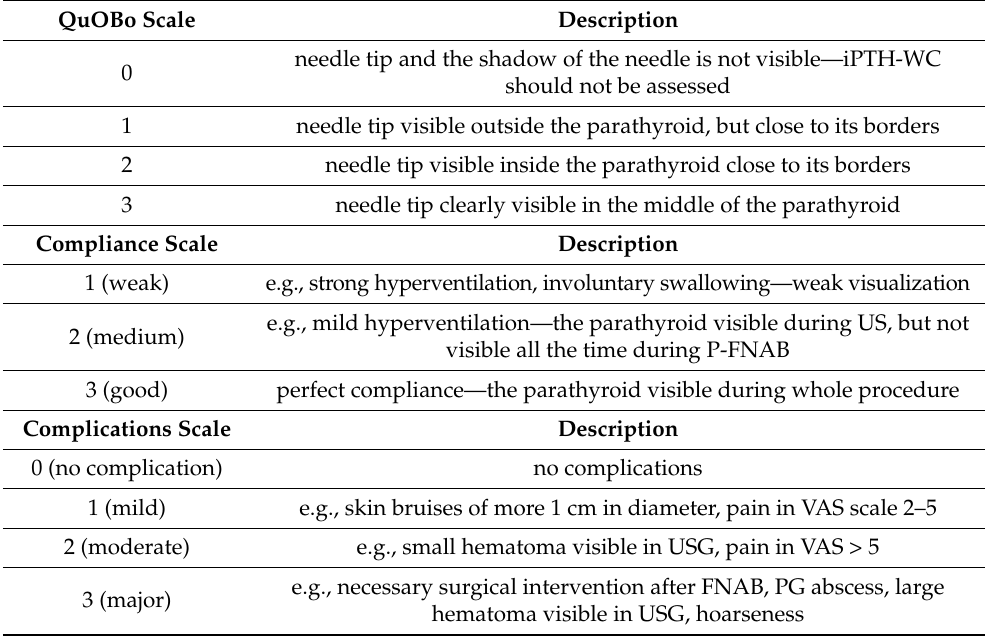
Table 1. Used scales during P-FNAB: QuOBo; Compliance and Complications scale description. QuOBo Scale needle tip and the shadow of the needle is not visible—iPTH-WC should not be